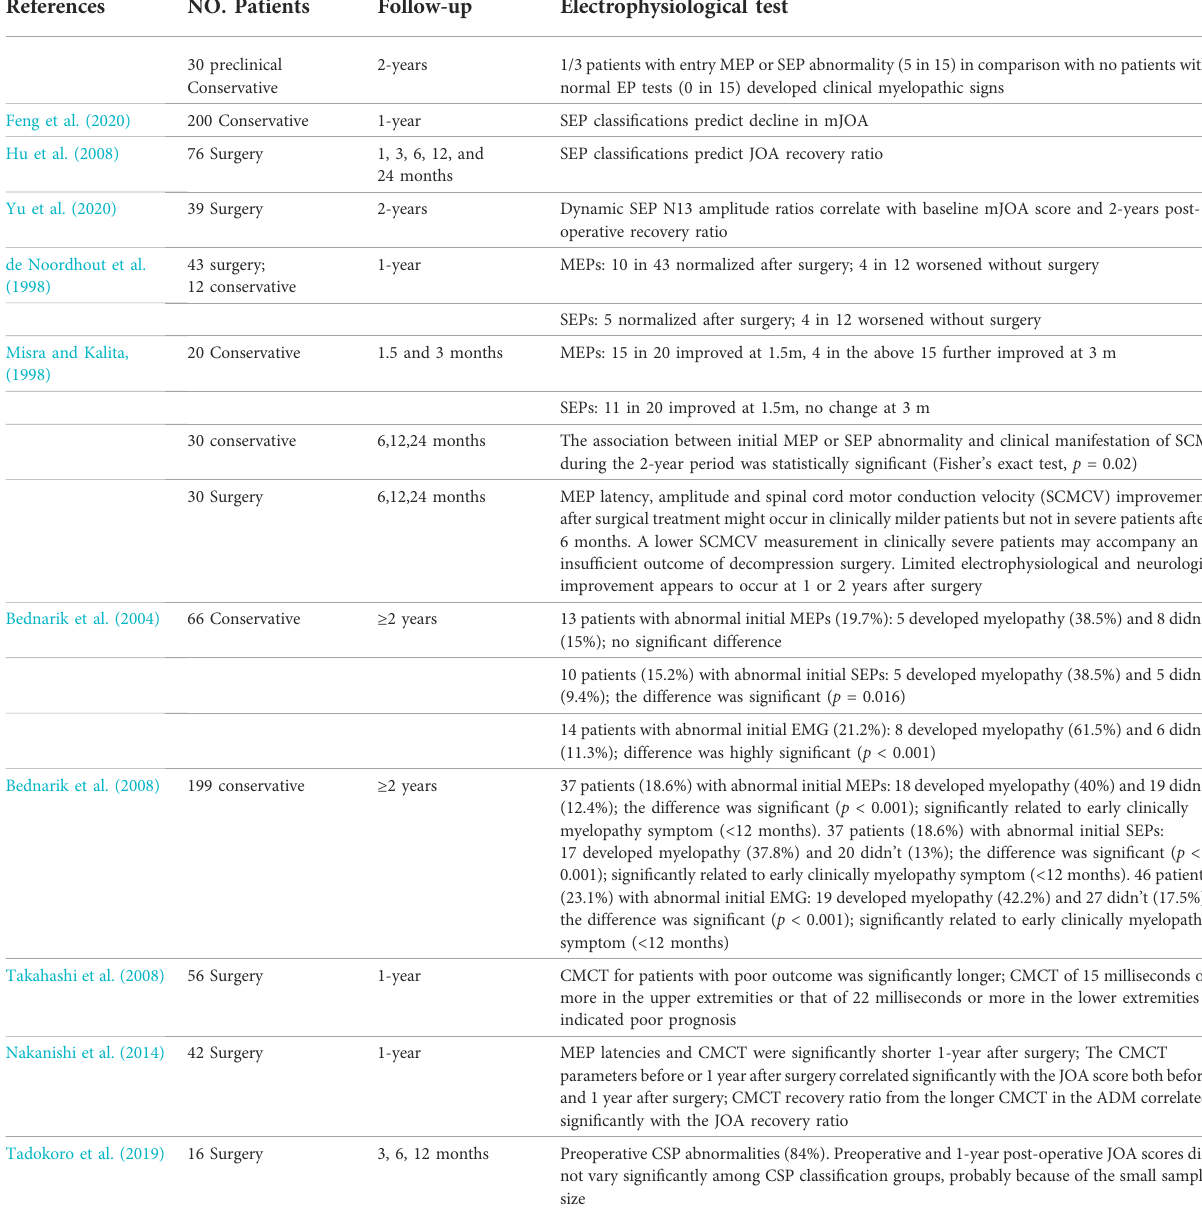
TABLE 3 Prognosis prediction by electrophysiological